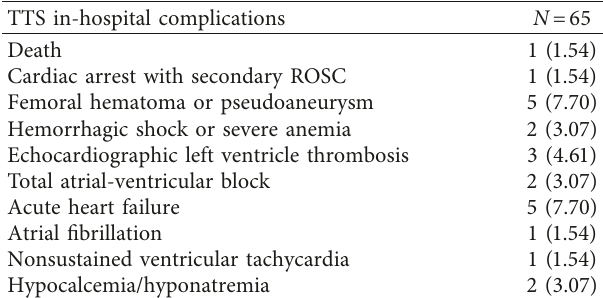
Table 2: TTS clinical complications during hospital